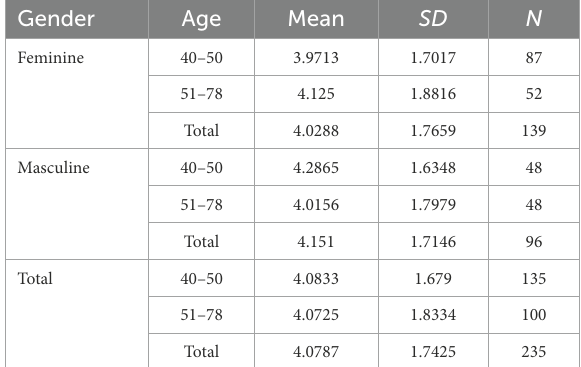
TABLE 4 The descriptive statistics for Two-way ANOVA [the dependent variable is Behavioral intention